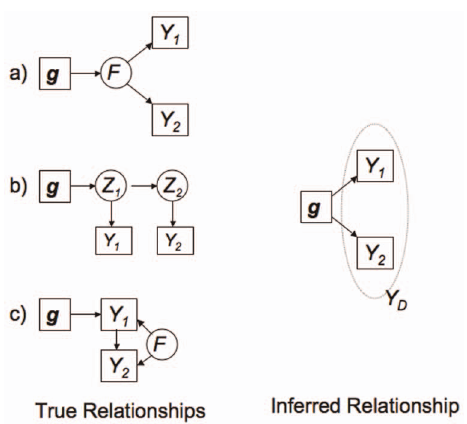
Figure 6. Illustration of potential complications in interpreting direct and indirect effects. The three graphs a)-c) on the left illustrate different hypothetical scenarios that could all lead to the inference that both Y 1 and Y 2 are directly associated with g (illustrated by the graph on the right). In each graph square nodes represent observed quantities, and circular nodes represent unobserved quanti- ties. In a) both Y 1 , Y 2 are indirectly associated with g via an unmeasured factor, F . In b) Y 1 and Y 2 are noisy observations of underlying variables Z 1 and Z 2 , where Z 2 is associated indirectly by via Z 1 . In c) Y 2 is associated with g indirectly via Y 1 , and an unmeasured factor F affects both of them. In all three cases both Y 1 and Y 2 are associated with g , and, further, due to the existence of unmeasured variables, Y 2 is conditionally dependent on g given Y 1 , leading to the inference (right) that both Y 1 and Y 2 are ‘‘directly’’ associated with g